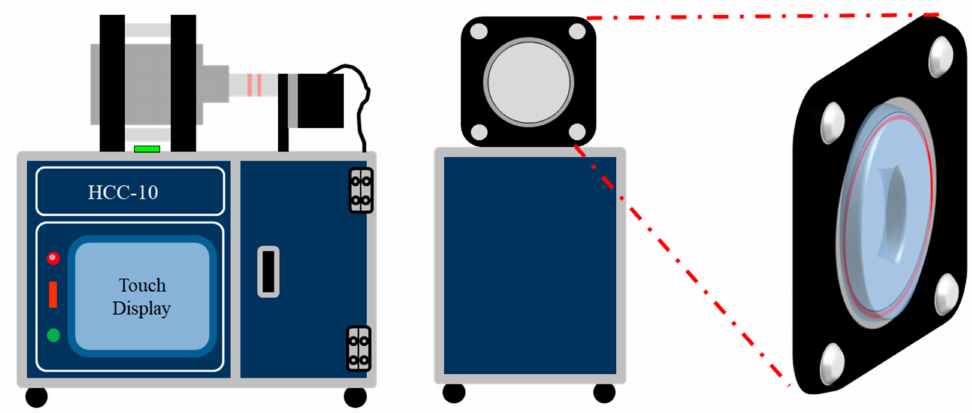
Figure 5. Apparatus for preparing pore-filled membrane: cylindrical centrifugal